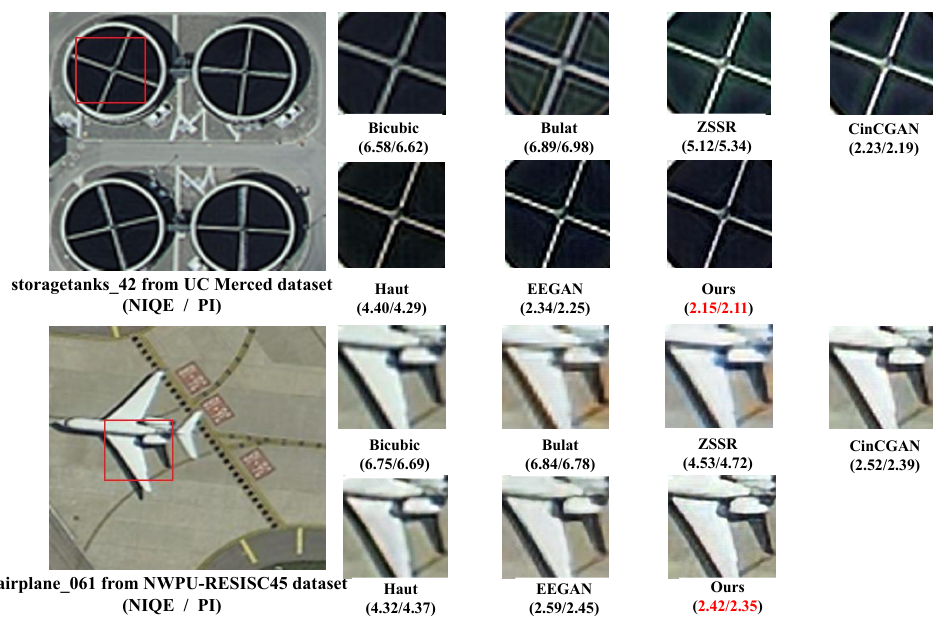
. For results . For results × × . For results × 100 pixels and 400 400. We 100 pixels and 400 400. We × × × × 100 pixels and 400 400. We × ×